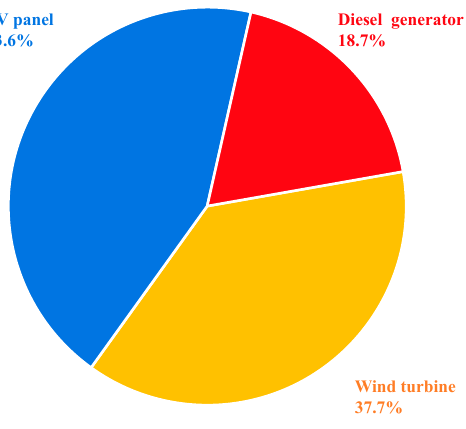
Figure 7. HES power distribution for the best configuration.